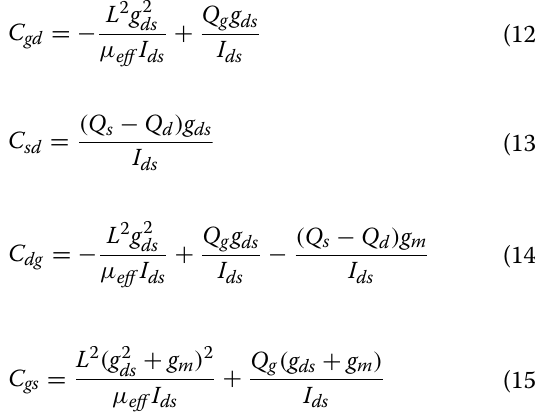
Fig. 6 Variation of Drain current I ds as a function of V ds for V gs in a SDG MOSFET. The proposed model is verified with the numerical simulation results obtained using MOSFet-PADRE tool